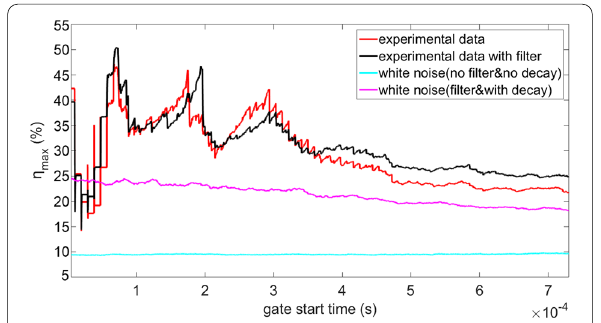
Figure 7 Diffuse field verification on white noise and experimental data using metric η max against gate start time